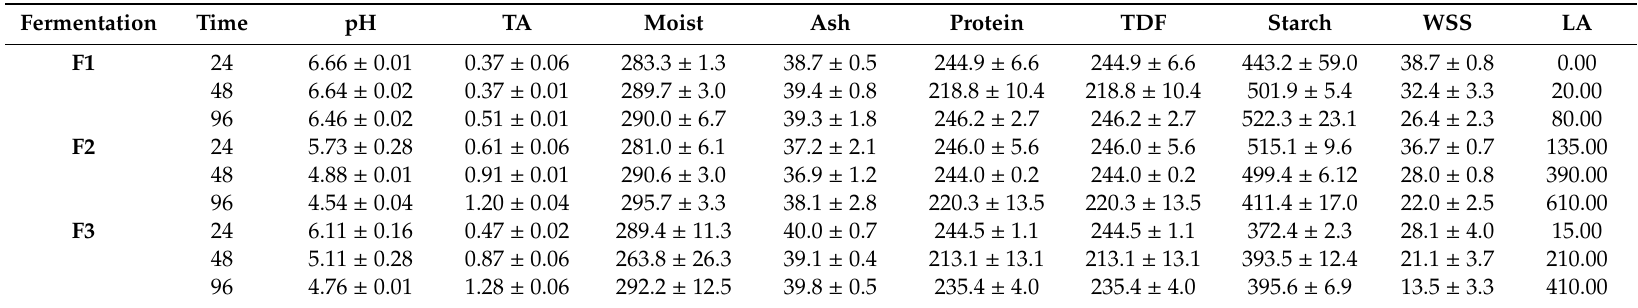
Table 4. Evolution of pH, TA, and nutritional characteristics (g · kg − 1 DM) of cowpea beans-flour not inoculated (F1, control), subjected to controlled fermentation with a single culture of Lactobacillus plantarum (F2) or inoculated with a consortium of L. plantarum , Oenococcus oeni, Saccharomyces cerevisiae and Acetobacter aceti (F3) along di ff erent times of fermentation (24, 48, 96 h). All experiments presented as mean values and respective standard deviation ( n = 18). Fermentation Time pH